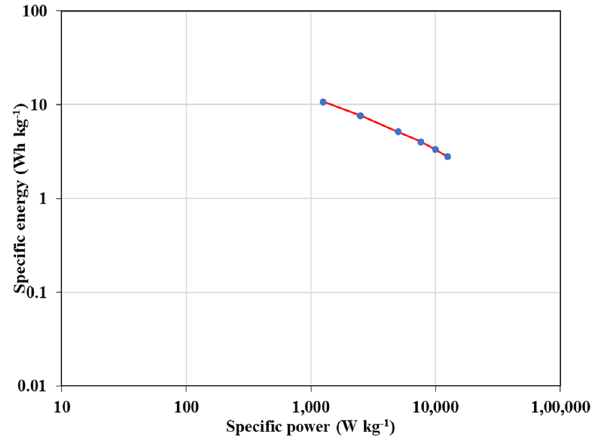
Figure 8. Ragone plot of α -MnO 2 /PANI/rGO nanocomposite and all its components.